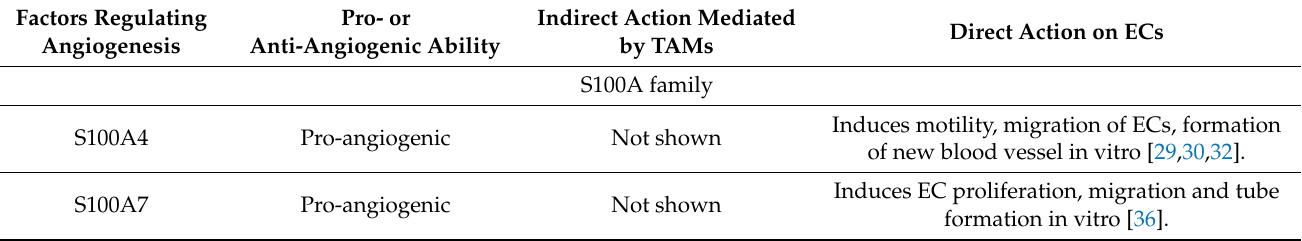
Table 1. Macrophage-derived factors involved in the regulation of tumor